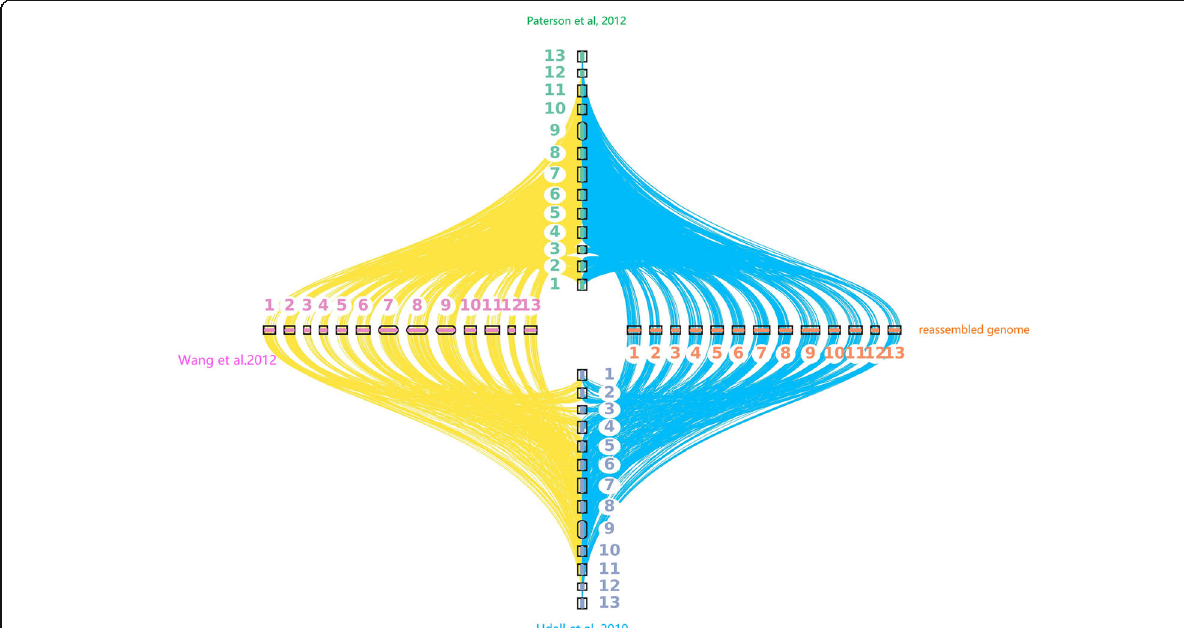
Fig. 3 The collinearity analysis of homologous genes between the reassemble genome, the draft genome (Wang et al. 2012) and reassembled genome (new) with two previous genome assemblies of G. raimondii (Paterson et al. 2012; Udall et al.